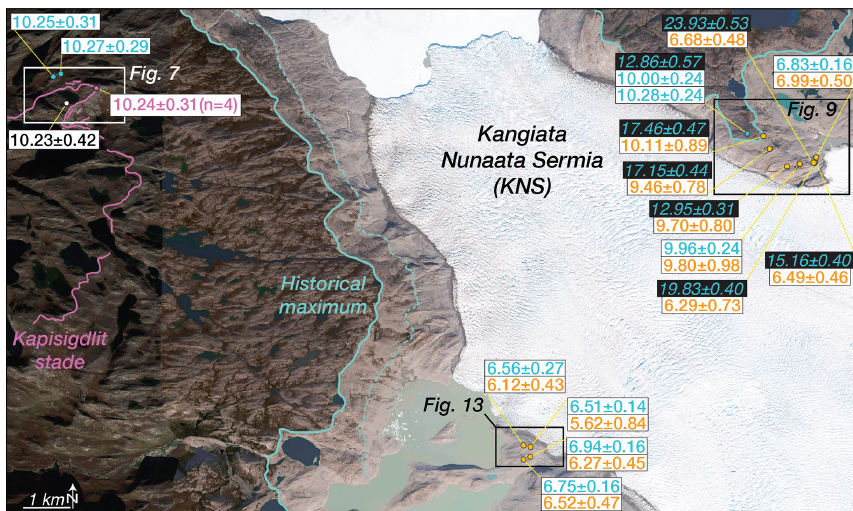
Figure 2. Kangiata Nunaata Sermia with the Kapisigdlit stade moraines (pink) and the historical maximum extent (blue), which is marked by prominent moraines and trimlines. The dashed line marks the 1920CE stade. For figure clarity, we only show 10 Be ages (ka ± 1SD) that constrain deposition of the Kapisigdlit stade moraine and do not include outliers; see Fig. 7 and Table S3 for a detailed view and the complete 10 Be dataset. For bedrock samples located inside the historical maximum extent, 10 Be ages (ka ± 1SD) are shown in blue text, and the corresponding in situ 14 C age from the same sample is in orange text (ka ± 1SD). 10 Be ages influenced by isotopic inheritance are in italics with black boxes. More detailed views of the bedrock sampling locations and the corresponding 26 Al / 10 Be ratios are shown in Figs. 9 and 13. Map data: © Google Maps, Maxar